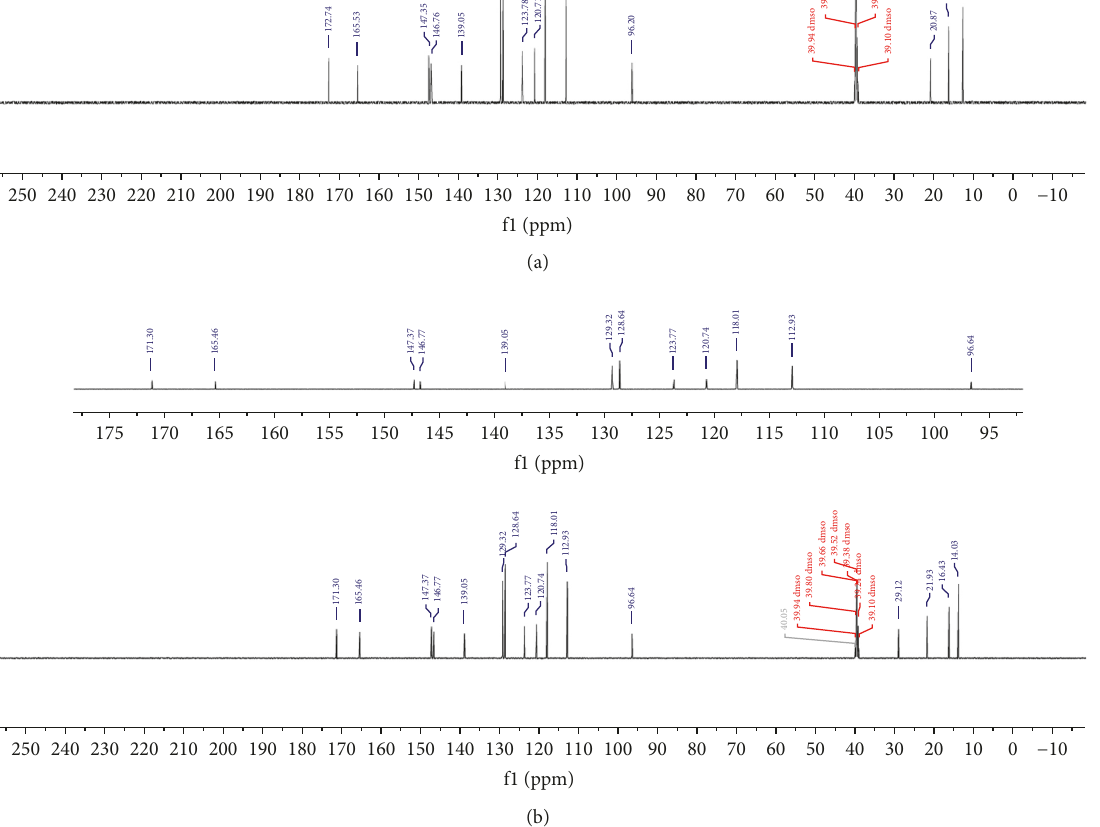
to centroid distances of 2.84 and 2.65 ˚A, respectively, Figure